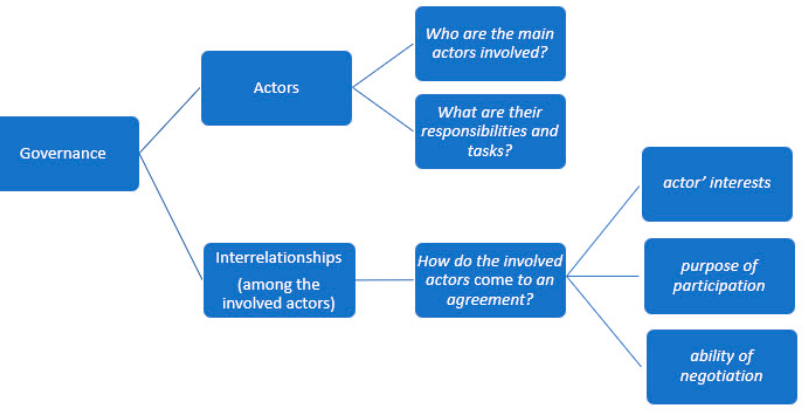
Figure 1. The analytical framework based on two governance elements (actors and interrelation- ships).